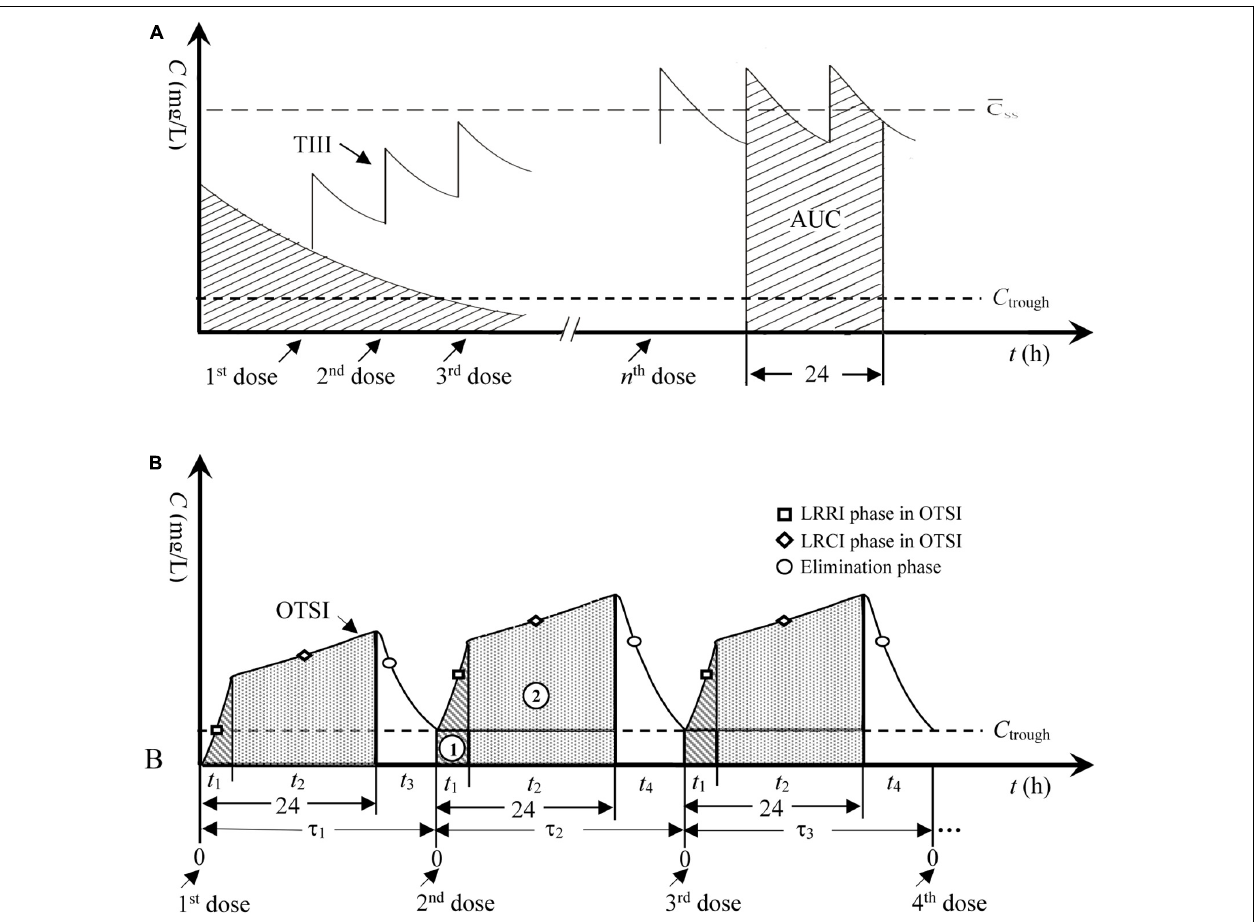
FIGURE 1 | Concentration-time profiles for TIII and OTSI. (A) TIII, traditional intermittent i.v. infusion; AUC, area under the concentration-time curve; ¯C ss , mean steady-state plasma concentration. (B) OTSI, optimal two-step infusion; τ 1 , dosing interval for the 2nd dose; τ 2 , dosing interval for the 3rd dose; τ 3 , dosing interval for the 4th dose; t 1 , infusion time in the LRRI phase; t 2 , infusion time in the LRCI phase; t 3 , or t 4 , duration in the elimination phase; (cid:192) , AUC in the LRRI phase; (cid:193) , AUC in the LRCI